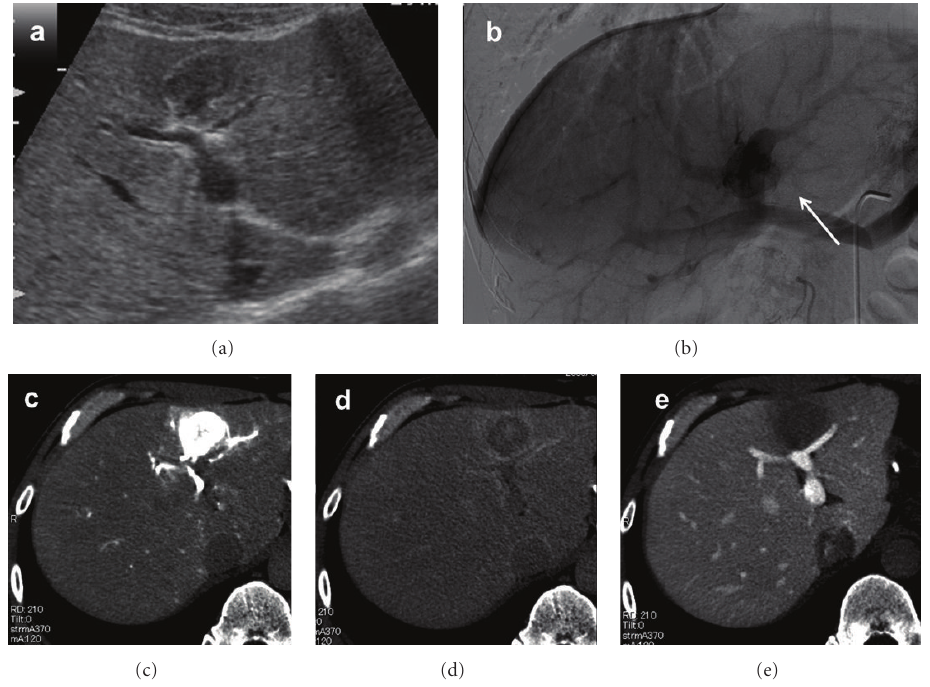
Figure 1: Imaging studies of HAML: (a) ultrasonography and (b) angiography. White arrow indicates the tumor staining in the portal venous phase. (c) 1st phase of CTA, (d) 2nd phase of CTA, and (e) CTAP. ((e) is from [12] with permission from Springer).